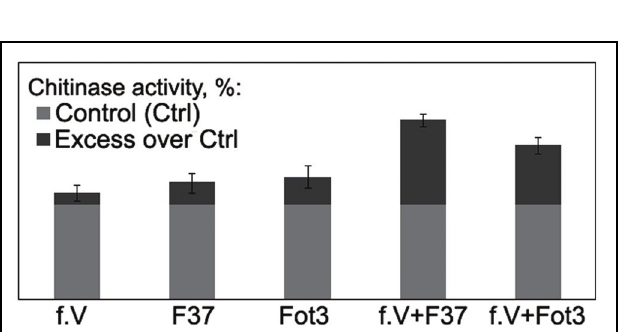
FIGURE 7 | Histograms showing percentage chitinase activity relative to control in root extracts obtained from tomato seedlings exposed to protein fraction V (f.V), pathogenic F. oxysporum f. sp. lycopersici strains F37 or Fot3 and in similar extracts from F37- or Fot3-inoculated seedlings, which were exposed to f.V prior to contact with pathogenic strains. The level of chitinase activity in extracts from roots of non-treated and non-inoculated seedlings are referred to as control (Ctrl) and taken as 100%. Presented data are means from one of two experiments, both of them showed similar results. Bars represent